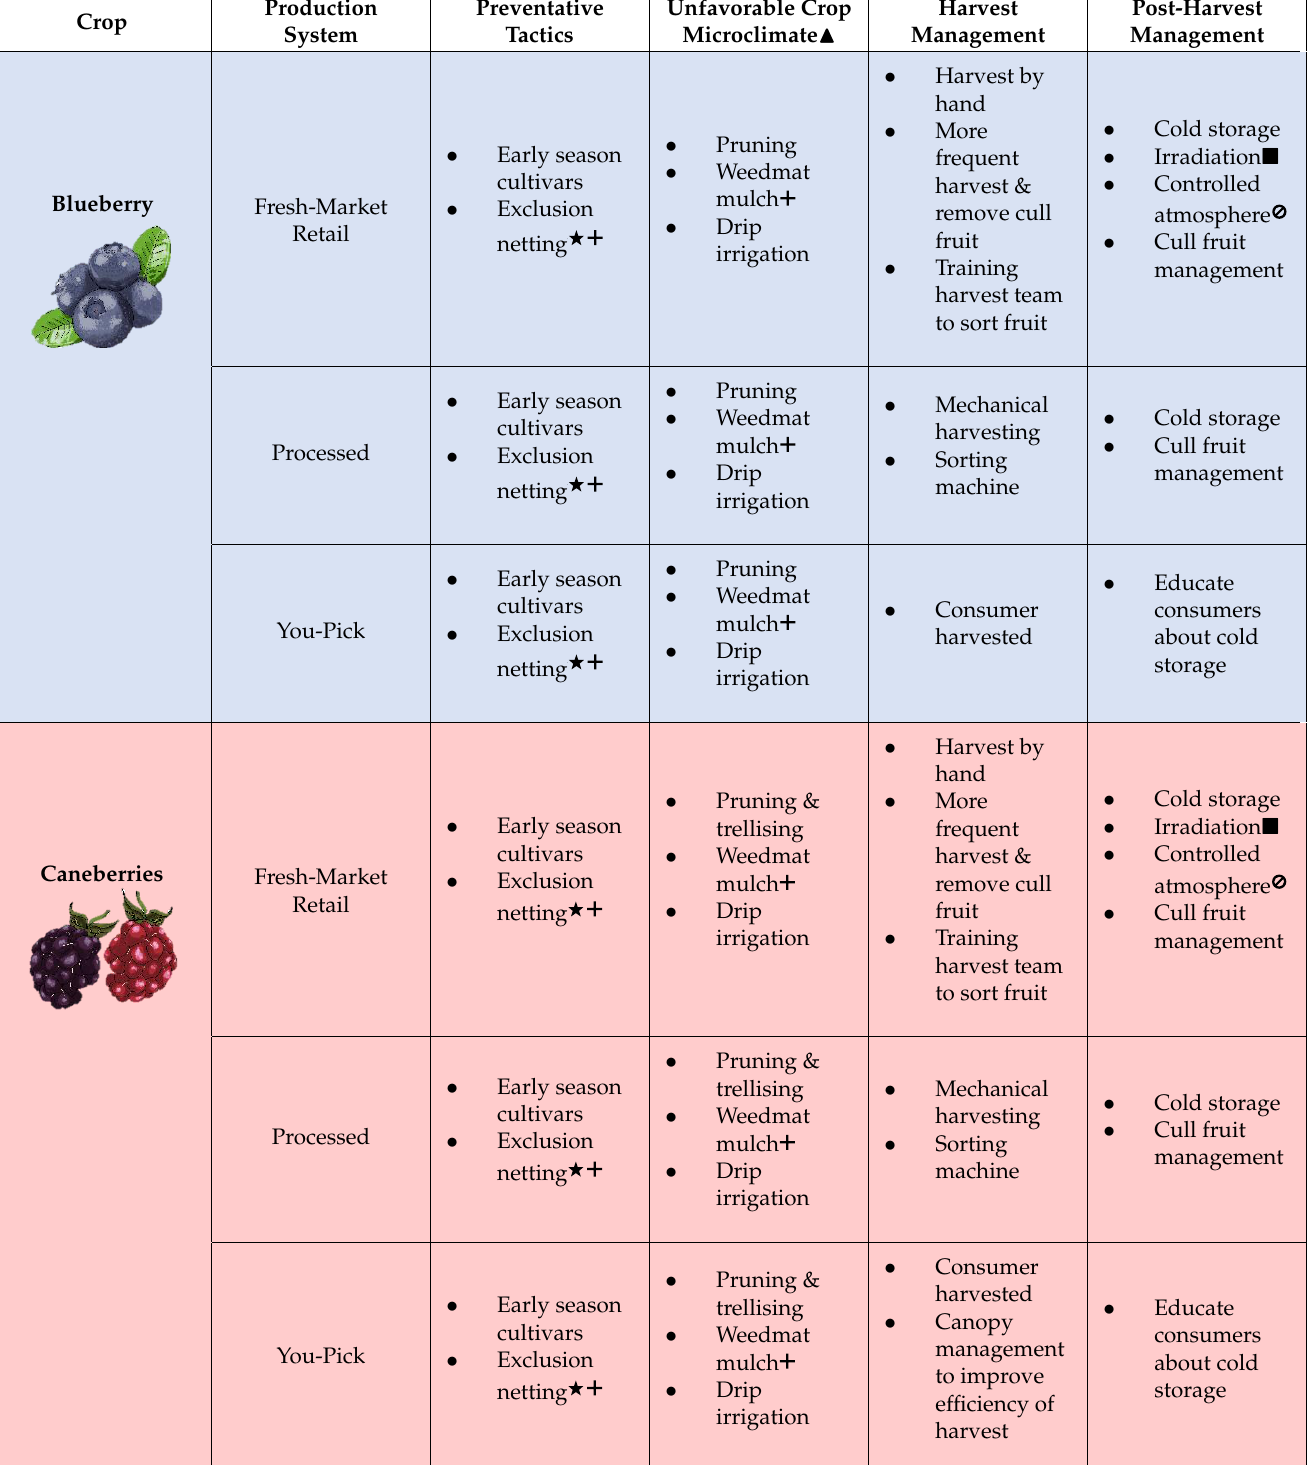
Table 1. Cultural control practices used to manage Drosophila suzukii in blueberries and caneberries in the U.S. Table Credit: Naiade Caparelli.